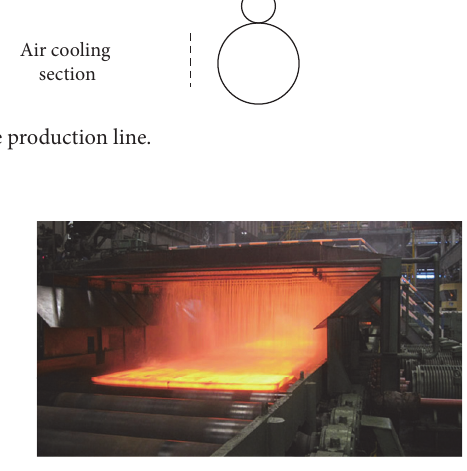
Figure 2: Working intermediate cooling